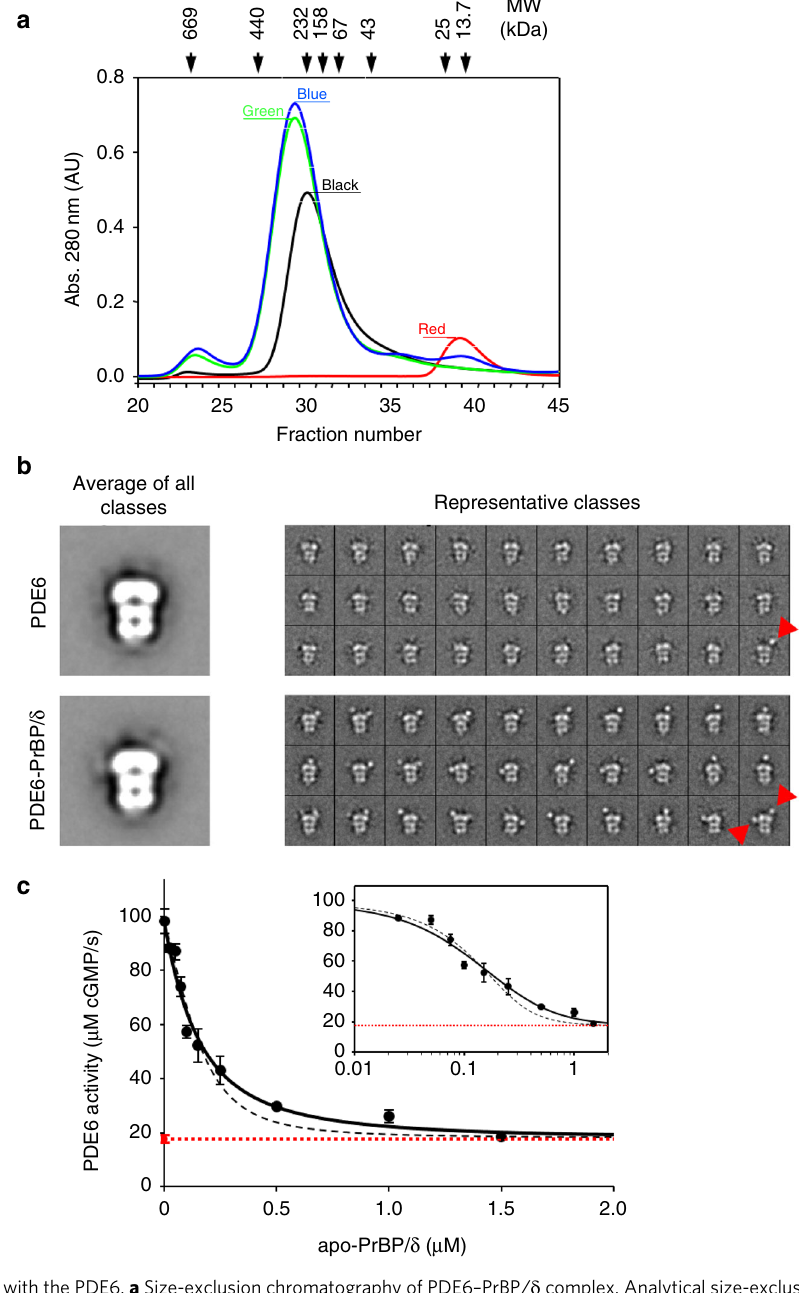
Fig. 4 Interaction of PrBP/ δ with the PDE6. a Size-exclusion chromatography of PDE6 – PrBP/ δ complex. Analytical size-exclusion chromatography con fi rms the stoichiometry of the complex as PDE6 – PrBP/ δ 2 . Runs for PDE6 only (black; molecular weight (MW) of ~217 kDa) and PrBP/ δ only (red; MW of ~17 kDa). Gel fi ltration reveals complex formation and peak shift for PDE6 – PrBP/ δ at ratios of 1:2 (green) and 1:3 (blue). Excess PrBP/ δ at the ratio of 1:3 (blue) elutes as a separate peak at MW of ~17 kDa (Supplementary Fig. 4). b Electron microscopy of the PDE6 – PrBP/ δ complex. Averages of all classes for PDE6 and PDE6 – PrBP/ δ complexes obtained by electron microscopy show a bell-shaped PDE6 molecule, where the densities at the top represent the more massive catalytic domains. Representative class-averages of PDE6 sample show one or two additional protruding densities for around 5% particles, which likely represents endogenous PrBP/ δ (~17 kDa) of the native sample. Representative class-averages of PDE6 – PrBP/ δ sample show one or two additional protruding densities for around 78% particles, which represents PDE-bound PrBP/ δ . Additional protruding densities are highlighted by red arrows in the lower right box of each panel of classes. c Activation assay of PDE6 as a monitor of PrBP/ δ induced solubilization of PDE6. G α *-induced activity of PDE6 (50 nM; circles) was measured as a function of PrBP/ δ concentration in the presence of isolated disc membranes (10 µ M) and G α * (1 µ M). Increasing concentration of PrBP/ δ progressively decreases PDE6 activity till it was equal to the PDE6 activity measured in solution (dotted red line). Data points were fi tted to a model with two different PrBP/ δ binding sites on PDE6 (solid black line; K = 0.04 ± 0.01 µ M and K = 0.7 ± 0.9 µ M; R 2 = 0.996) or with two 1 2 identical binding sites (dashed gray line; K = 0.07 ± 0.01 µ M; R 2 = 0.994). Inset: semi-logarithmic replot of the data. All data points are replicates of three measurements depicted with standard